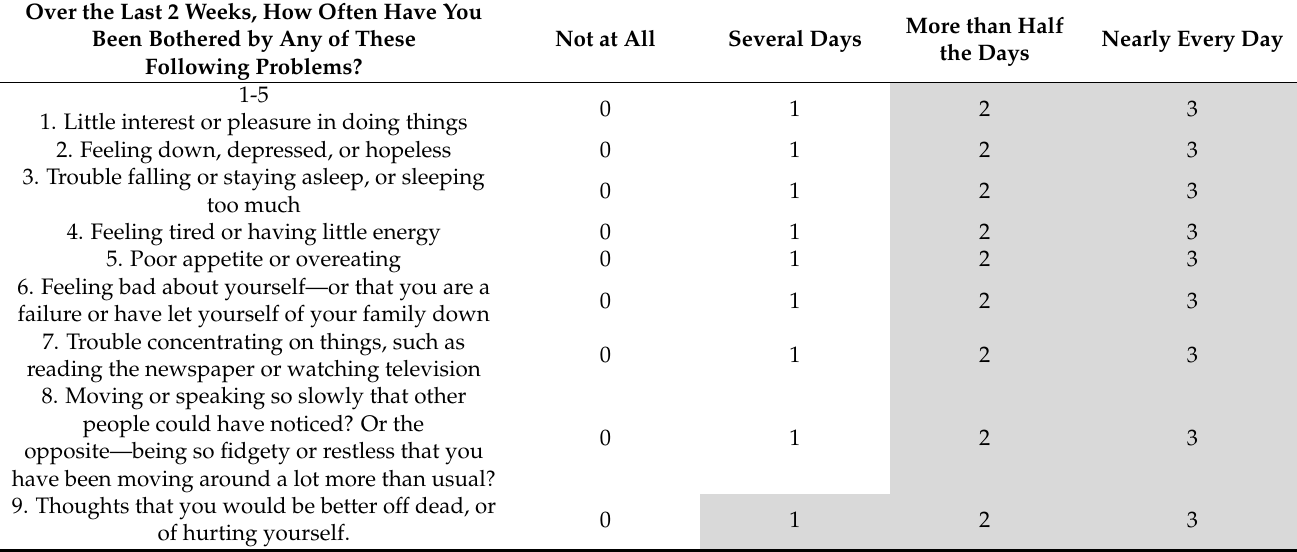
Table 1. Patient Health Questionnaire